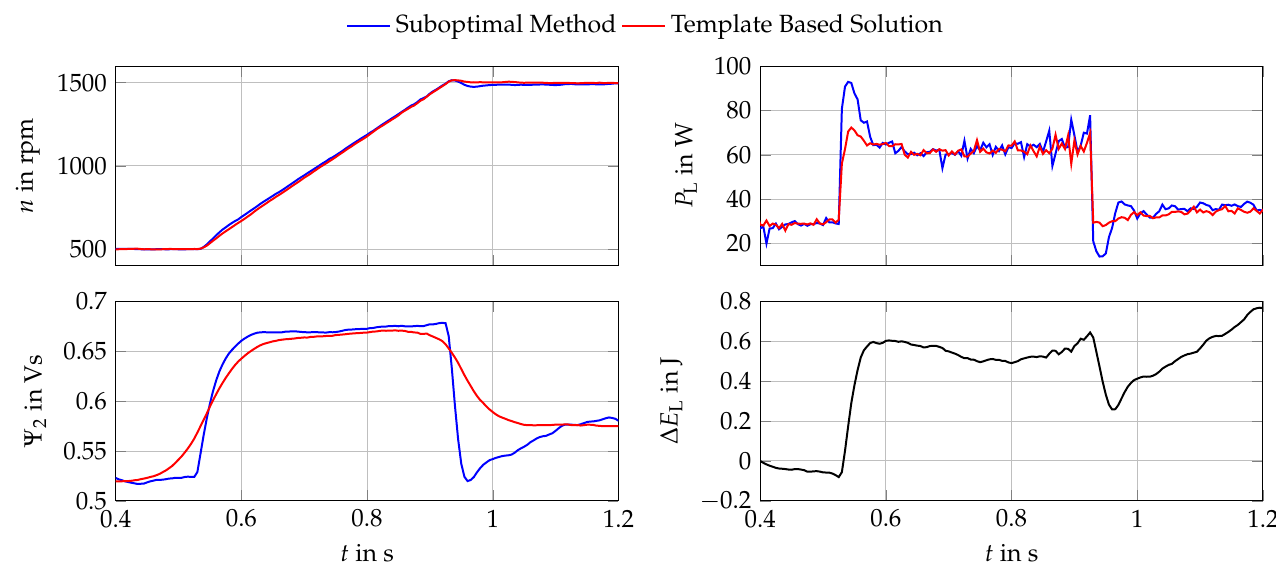
Figure 17. Measurement results for anticipative flux